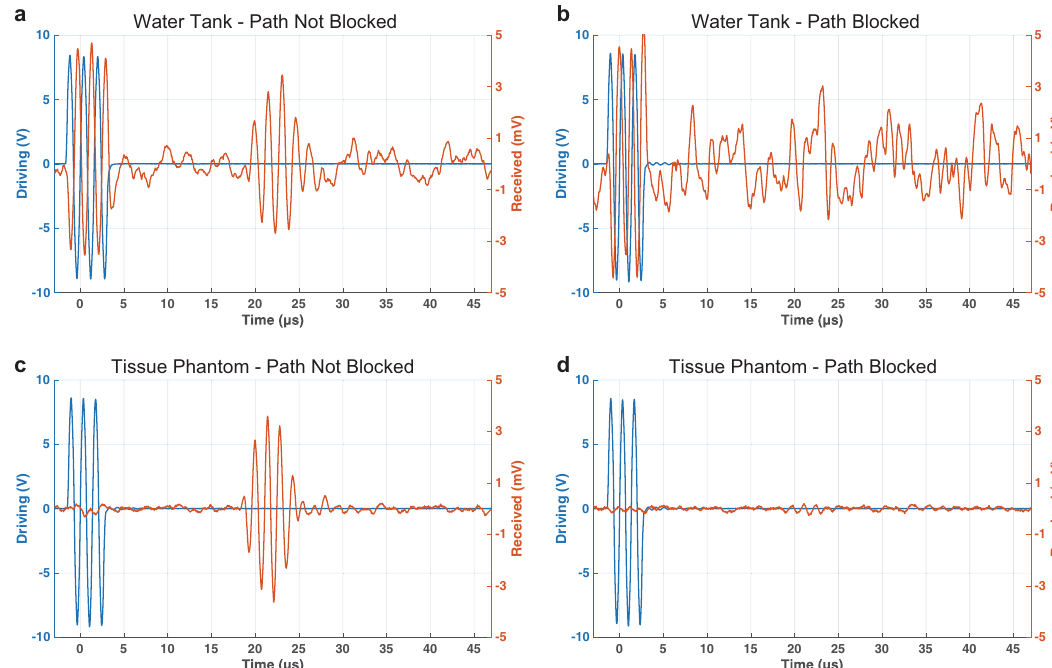
Fig. 10 Time-domain comparison of pulse transmission. a Pulse transmission in water with path not blocked. Both ultrasonic pulse and capacitive coupling signals are present. b Pulse transmission in water with path blocked, only capacitive coupling is present. c Pulse transmission in tissue phantom, only the ultrasonic pulse is present, and the capacitive signal disappeared. d Pulse transmission in tissue phantom with path blocked, the ultrasonic pulse disappears as